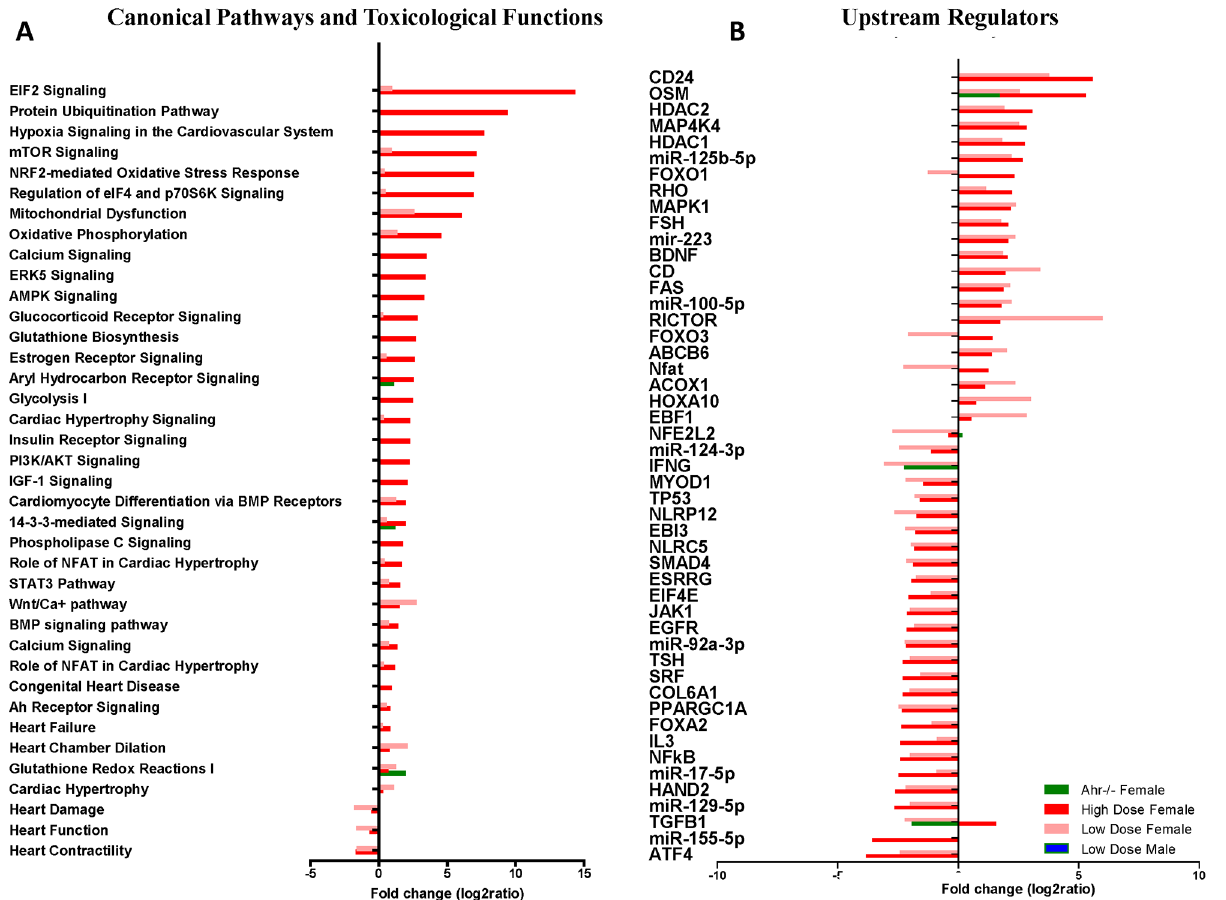
Fig 3. Differentially expressed canonical pathways, toxicological functions, and upstream regulators underlie AHR disruption-driven altered structure and function. (A) Fold change expression of differentially expressed Ingenuity Pathway Analysis (IPA) canonical pathways and toxicological functions from and Ahr -/- females and high and low dose TCDD-exposed females relative to na ï ve Ahr +/+ . (B) IPA ’ s upstream regulators from and Ahr -/- and high and low dose TCDD-exposed mice relative to na ï ve Ahr +/+